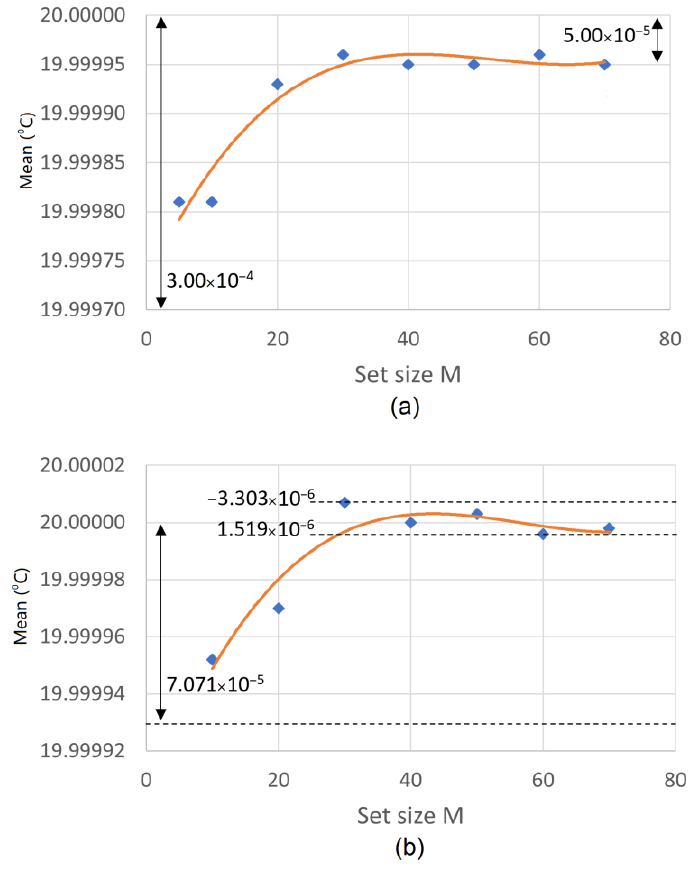
Figure 8. Variation in the mean and variance for ( a ) N = 10 and ( b ) N = 200.